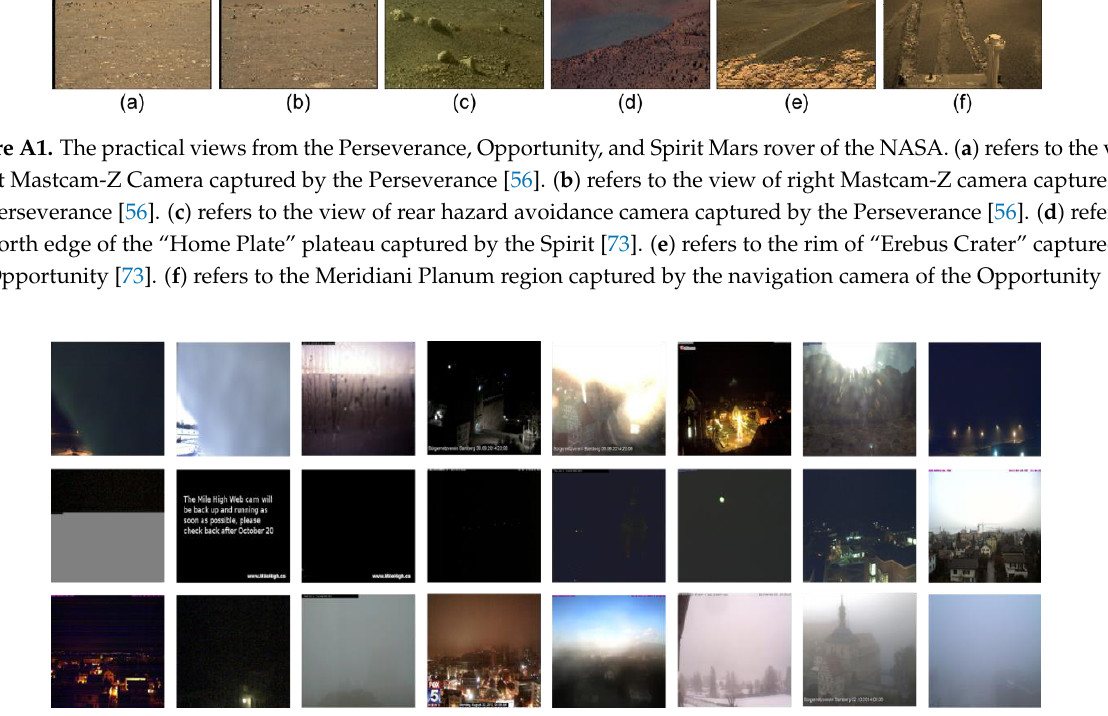
Figure A2. The examples of the deleted images from the Skyfinder dataset. The images have been resized to same height and width for better displaying. The deleted images are mainly extremely upset visual condition, which is meaningless as a vision data. For example, the damaged image, purely dark (or white), extremely bad visibility (huge occlusion, backlight, noises, fog, cloud, rain, and etc.).